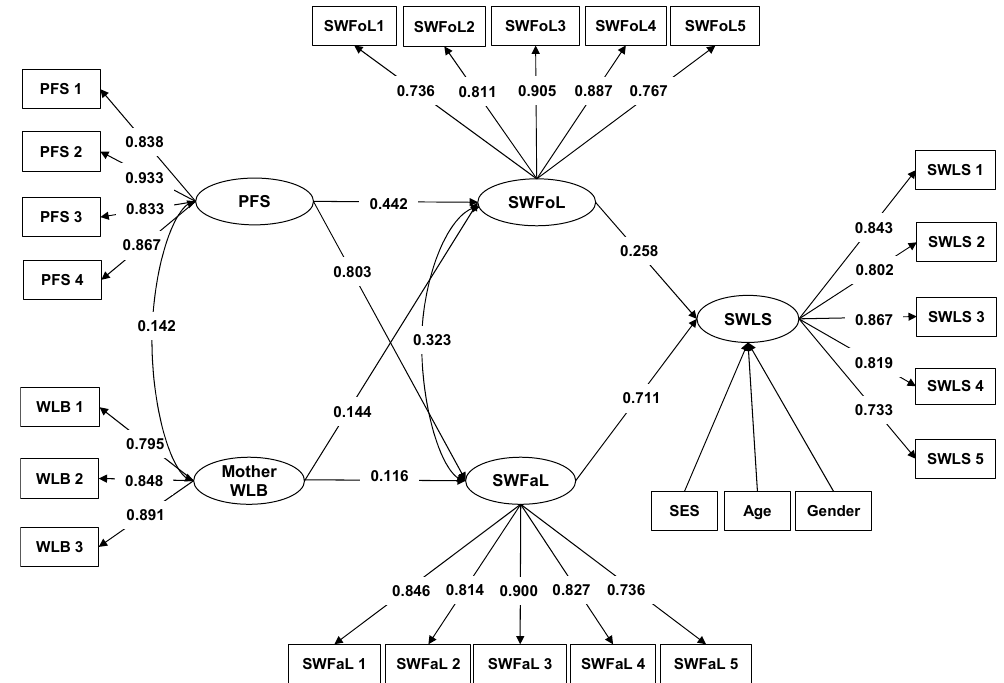
Figure 1. Path diagram of the model that explains the relationships between Perceived Family Support (PFS), mother’s Work-life Balance (Mother WLB) and Satisfaction with Family Life (SWFaL) and Satisfaction with Food-related Life (SWFoL) and between SWFoL, SWFaL and Satisfaction with Life Scale (SWLS) in adolescents. SES: Socioeconomic status. Only significant path coefficients are shown ( p < 0.05). The items of each scale are shown in the Appendix A .